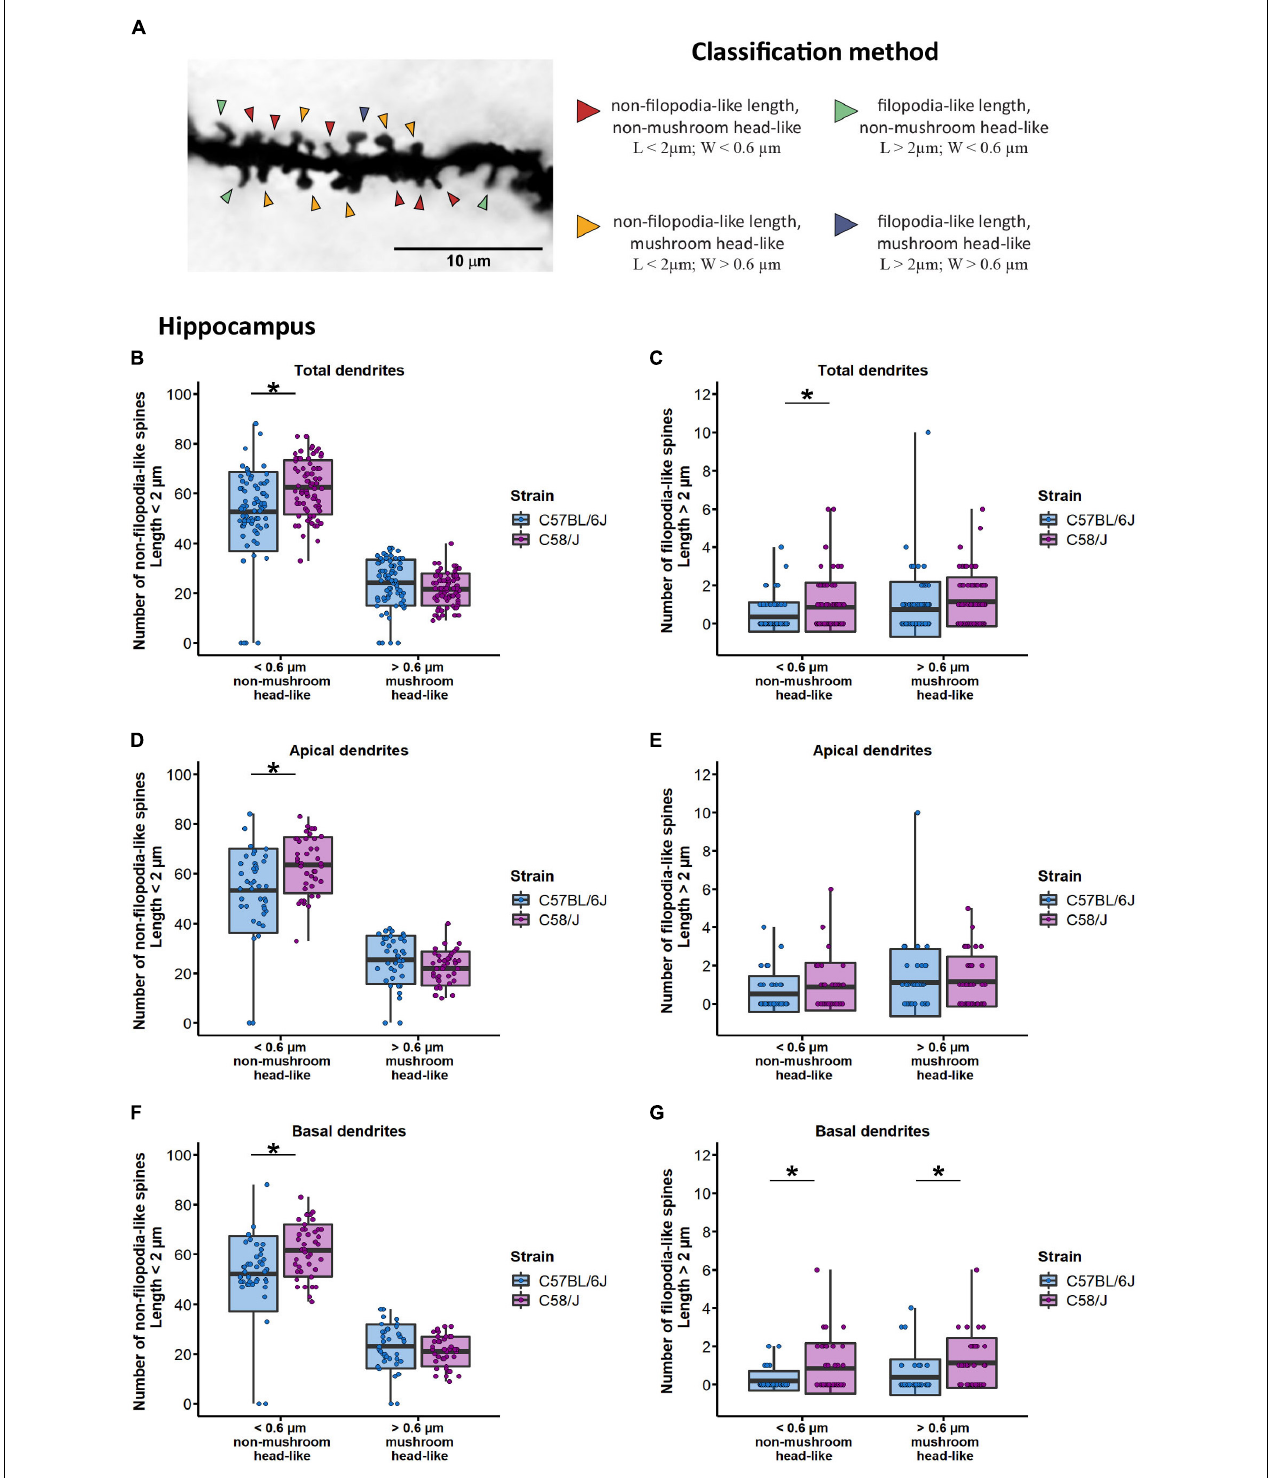
FIGURE 4 | Classification of dendritic spines by shape type in the hippocampus of C58/J mice. Representative image of spine classification by shape type (A) . Arrowheads are pointing to examples of each shape type. Dendritic spines were categorized depending on their length into filopodia-like or non-filopodia-like, and by their width, as mushroom head-like or non-mushroom head-like, in total (B,C) , apical (D,E) , and basal (F,G) dendrites of pyramidal neurons in the hippocampus of C57 BL/6J (neurotypical phenotype) and C58/J (autistic-like phenotype) mice. Results are expressed as mean ± SD; n = 20 neurons per strain, five neurons per mouse. t -test with Holm–Bonferroni correction: * p <